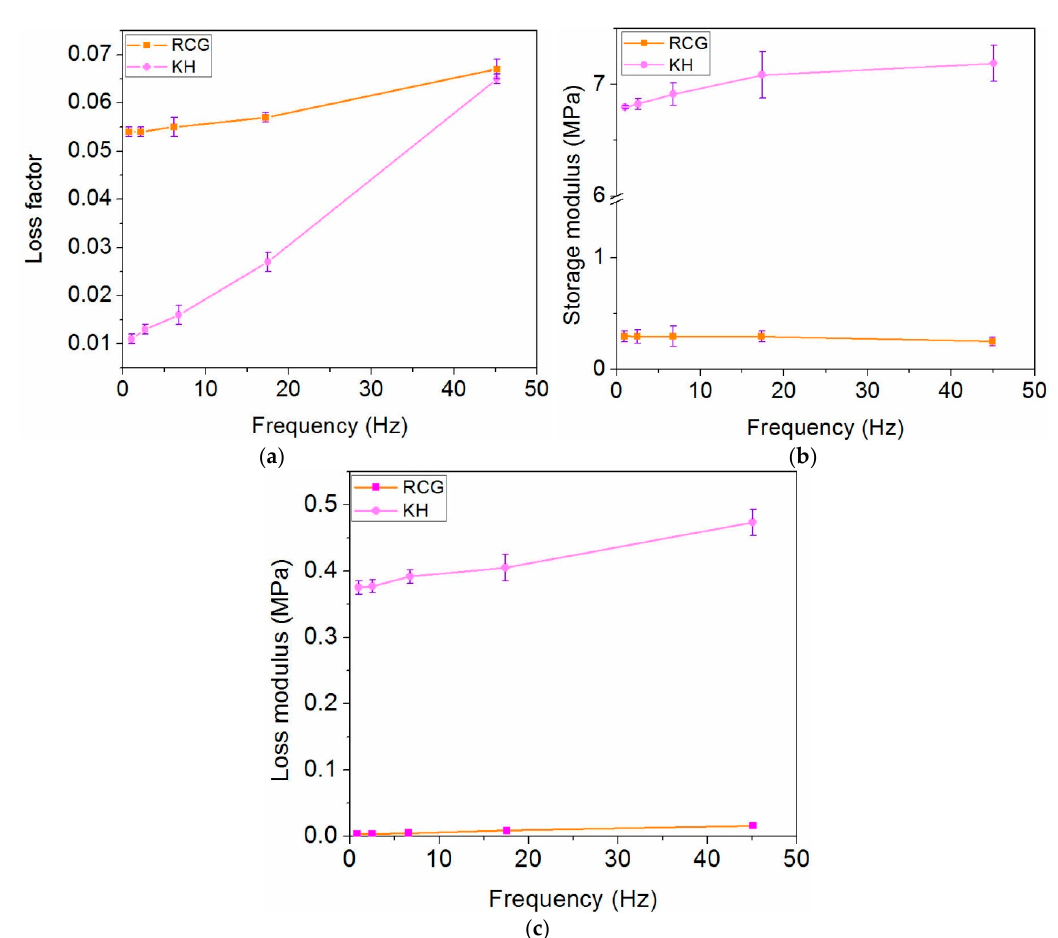
Figure 5. Dynamic nanoindentation analysis for electrospun RCG and KH nanofibers. ( a ) Loss factor. ( b ) Storage modulus (E ′ ). ( c ) Loss modulus (E ′′ ).